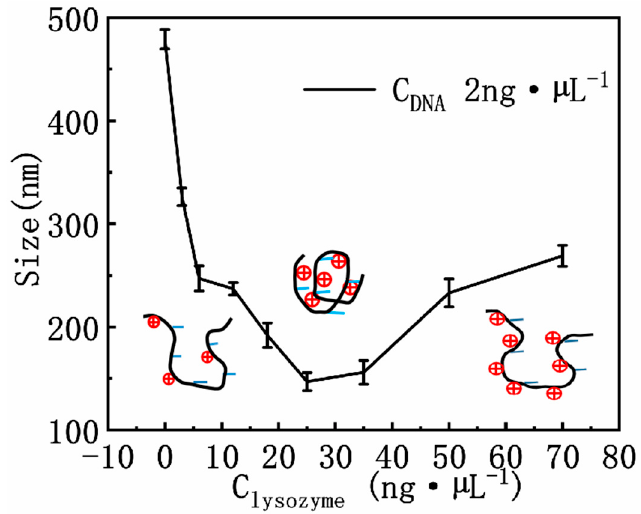
Figure 6. The size of DNA as a function of different lysozyme concentration. The error bars repre- sent the corrected sample standard deviation. the corrected sample standard